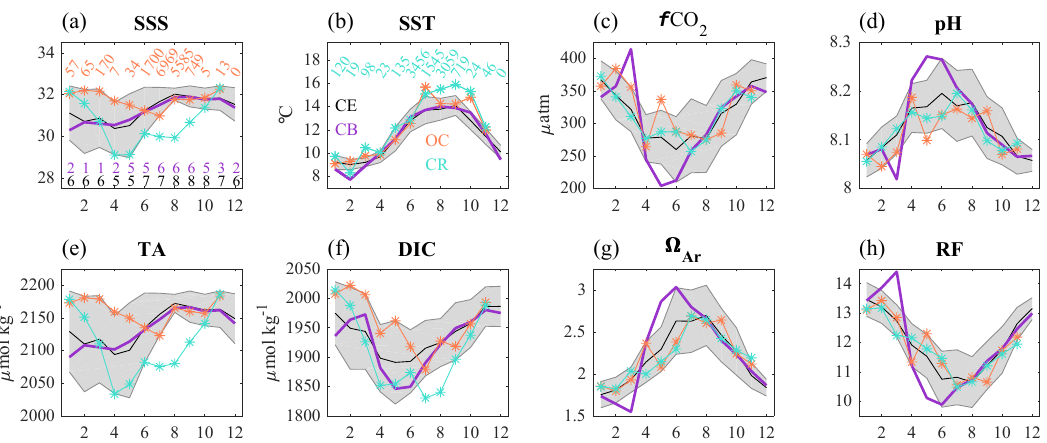
Figure D1. Seasonal cycles of (a) SSS, (b) SST, (c) f CO 2 , (d) pH T , (e) TA, (f) DIC, (g) (cid:127) Ar , and (h) RF at the Cape Elizabeth (CE) and Chá b˘a (CB) moorings and for the Outer Coast (OC) and Columbia River (CR) regions. Gray shading shows ± 1 σ for CE. Text near the bottom of (a) indicates the number of years of moored SSS, SST, and f CO 2 observations contributing to the monthly seasonal cycle estimates. Slanted text in (a) and (b) indicates the total number of discrete observations contributing to the monthly seasonal cycle estimates.